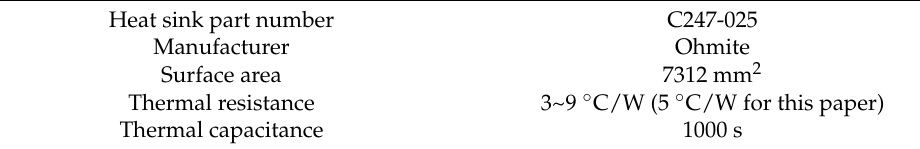
Table 5. Heat sink thermal